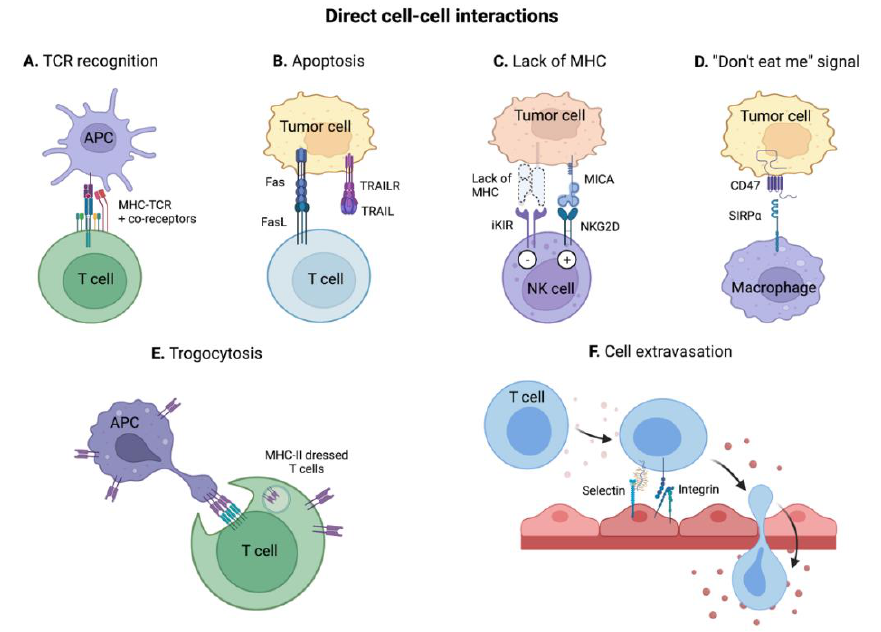
Figure 3. Direct cell-cell receptor interactions controlling essential immune mechanisms in the TME. ( A ) Tumor antigen recognition and education of T cells via the MHC-TCR interaction. ( B ) Apoptosis induction by cell death ligands. ( C ) NK cell activation by the lack of MHC-I or of oncogenic stress. ( D ) Phagocytosis inhibition by the expression of “do not eat me” signals by tumor cells. ( E ) Transfer